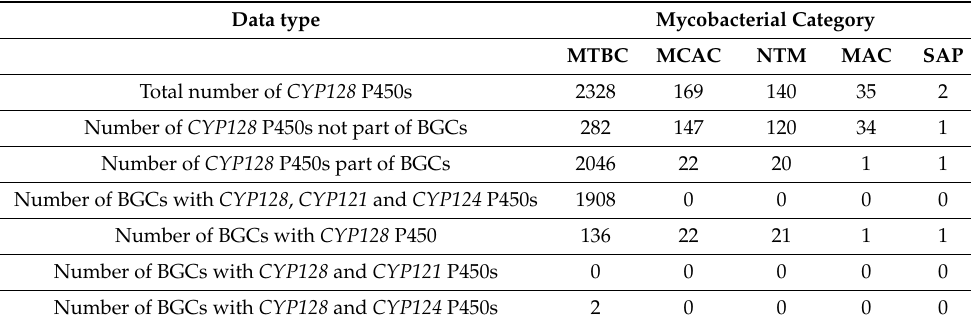
Table 2. CYP128 P450 gene cluster analysis in five mycobacterial category species.